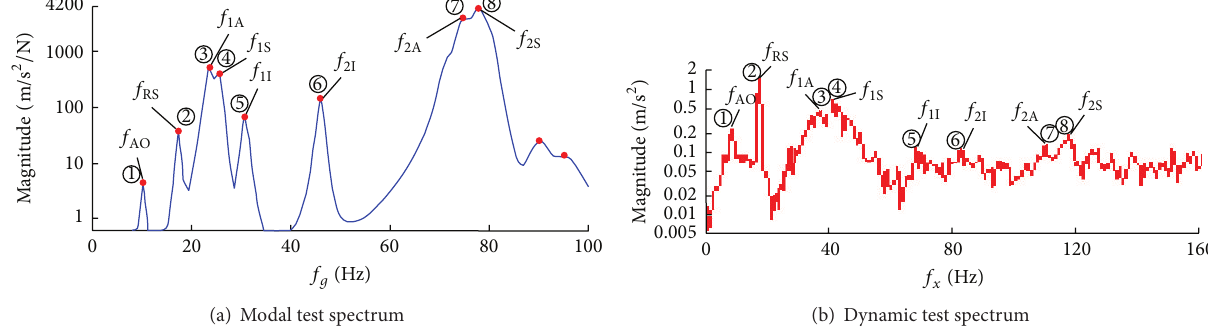
Figure 9: Determination of dynamic frequency of wind wheel.